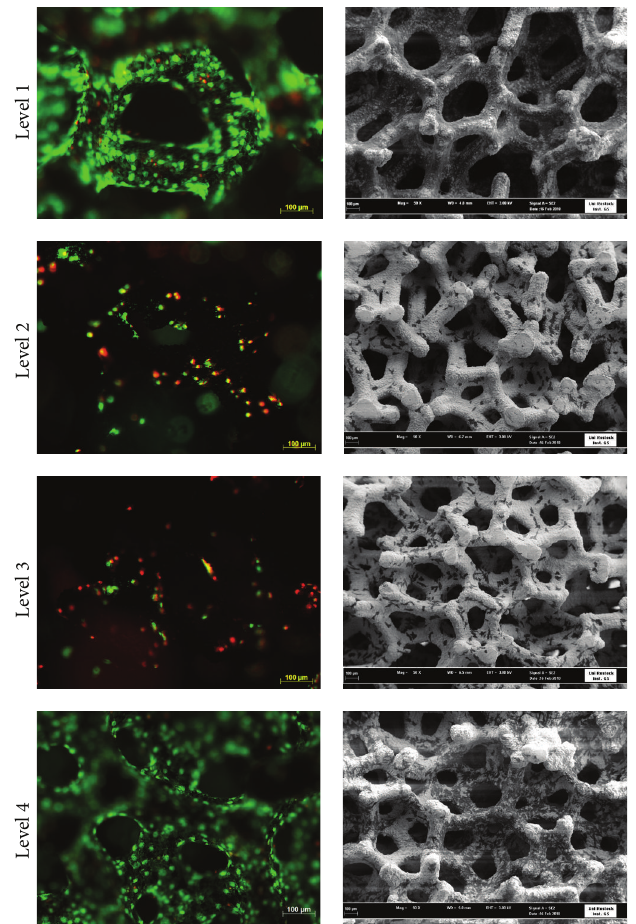
Figure 6: Static cell culture in the in vitro 3D module. Fluorescence (left) and FESEM images (right) of MG-63 cells after culturing for 7 days. Lower cell density and dead cells could be detected in the core region (levels 2 and 3). Fluorescence images: nuclei of vital cells = green, nuclei of dead cells = red (Axio Scope.A1, magnification 10x, bar 100 𝜇 m) and FESEM images: Ta = white, cells = black (FESEM SUPRA 25, magnification 50x, bar 100 𝜇